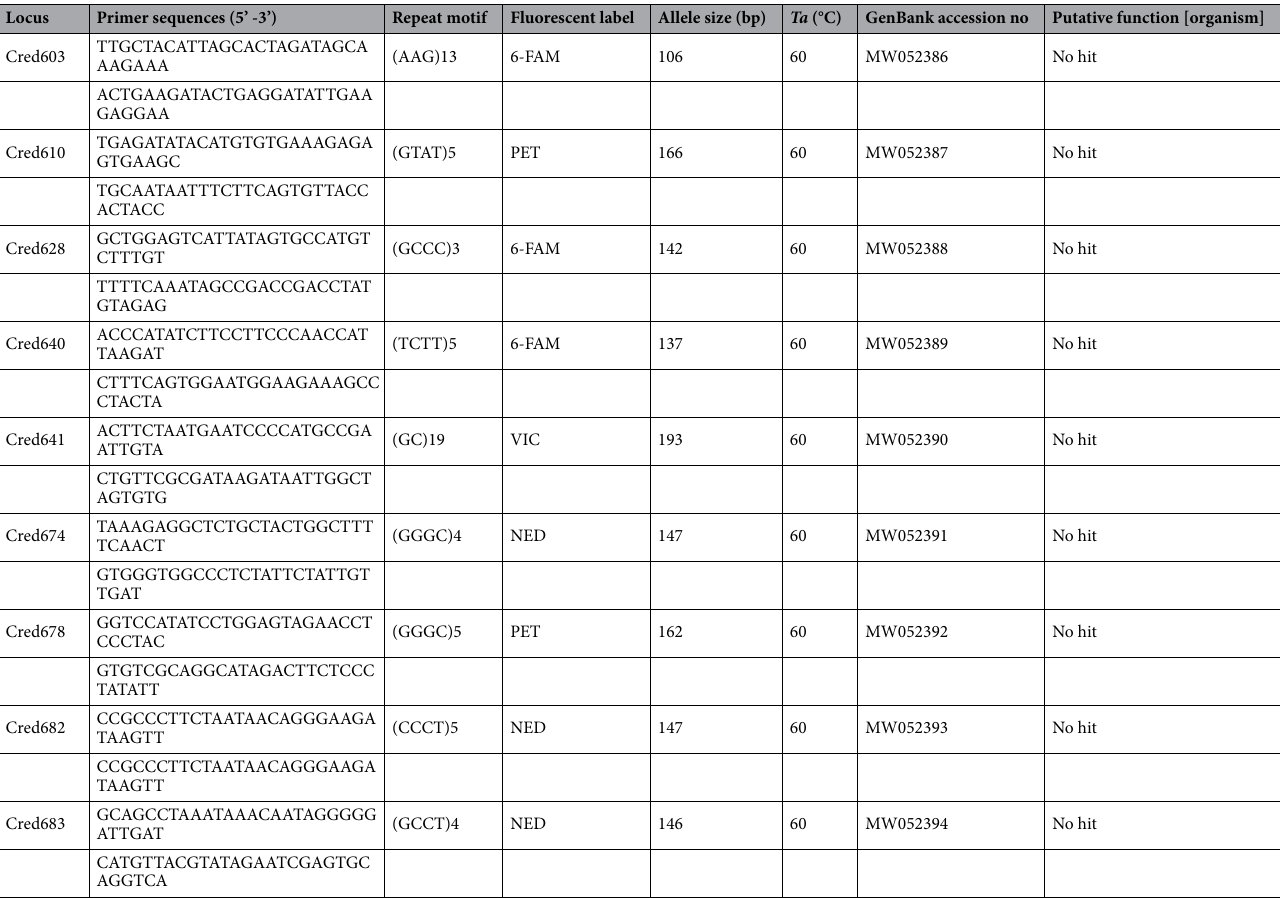
Table 1. Characteristics of 9 SSR loci developed in Chamaecyparis formosensis